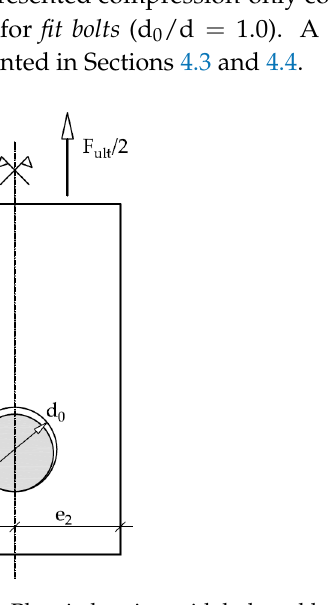
( d ) Figure 15. Collapse mechanisms (blue: Slip displacements, red: Normal displacements) from DLO at the compression-only support for different node distributions (top row: Coarse mesh; bottom row: